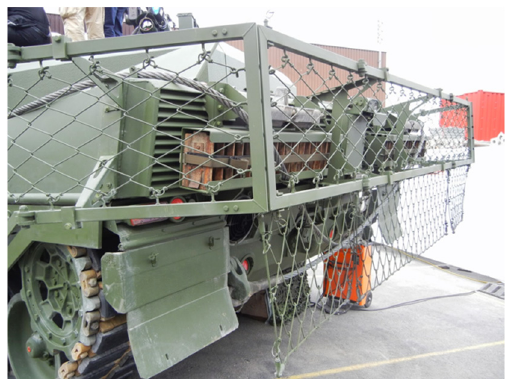
Figure 7. Metal fibre-based net armour system.